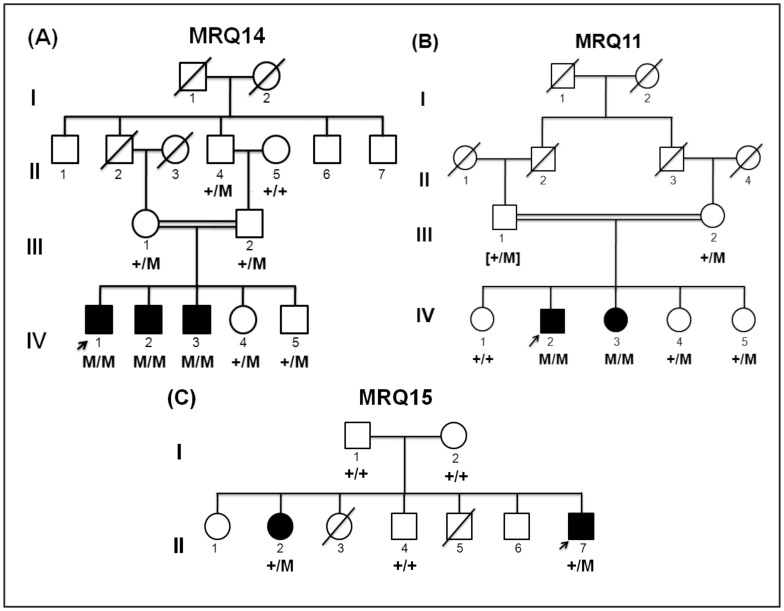
Pedigree of families (A) MRQ14, (B) MRQ11 and (C) MRQ15.The segregation of mutation of KMT2B, ZNF589 and HHAT are also in the pedigree. The symbol +/+ represents homozygous ancestral alleles, M/M is for homozygous variant alleles and +/M is for heterozygous carriers. In the panel B, the genotype of the father (III:1) has been deduced.